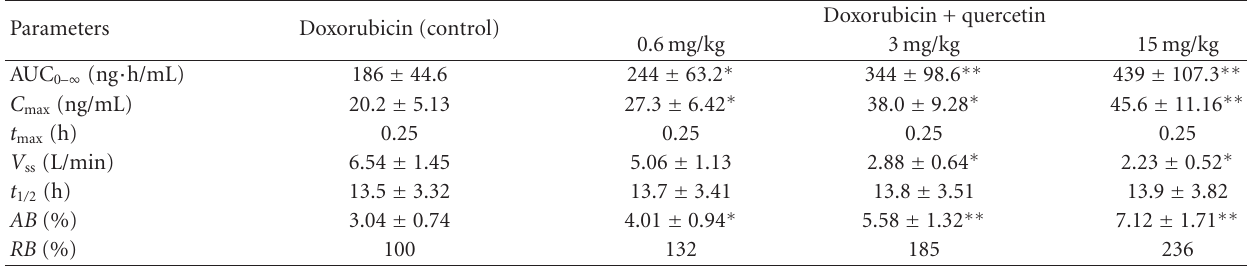
Doxorubicin + quercetin 0.6 mg/kg